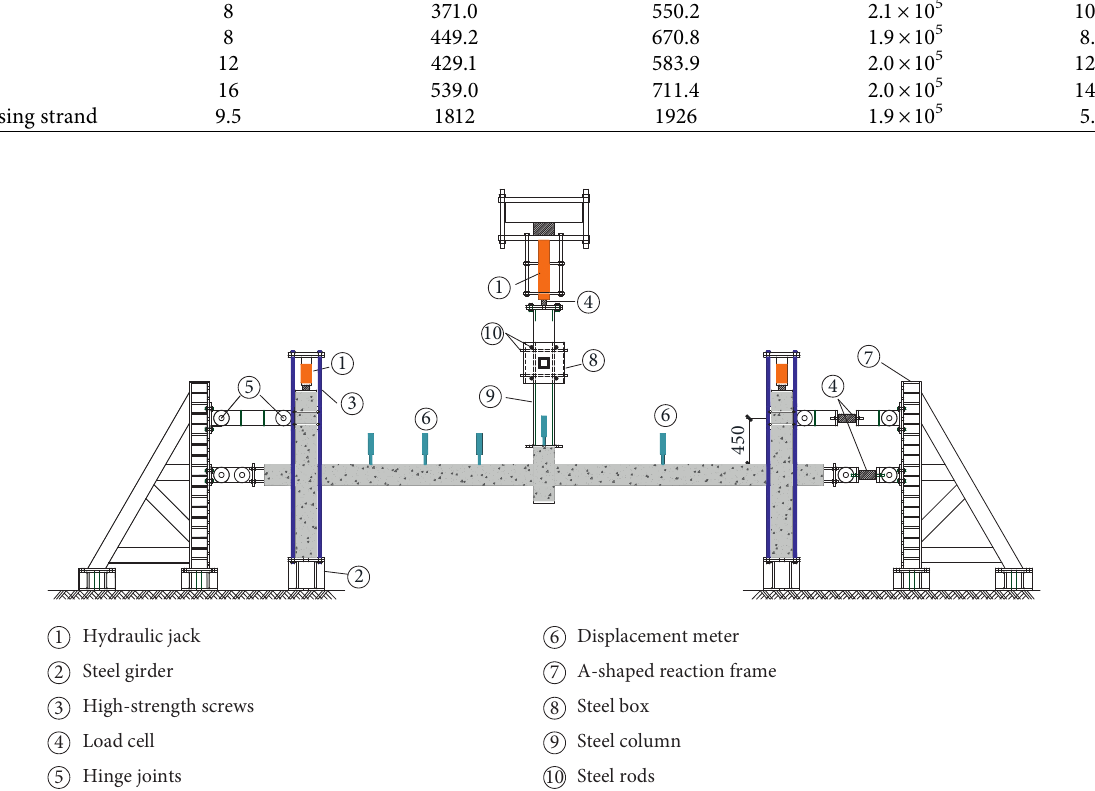
Figure 4: Specimen assembly.